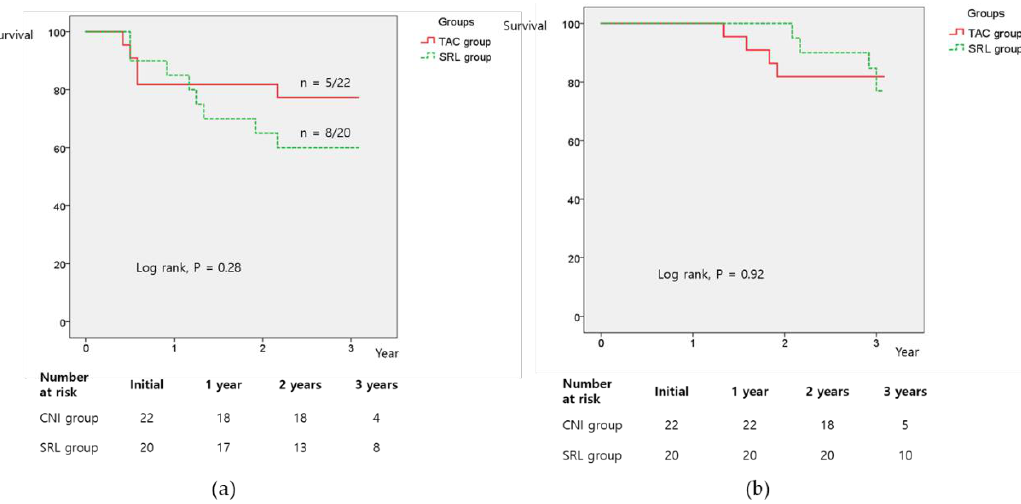
Figure 2. Kaplan-Meier analysis of ( a ) recurrence-free survival and ( b ) overall survival of patients in the sirolimus (SRL) and tacrolimus (TAC) groups. No significant differences were found between the two groups.